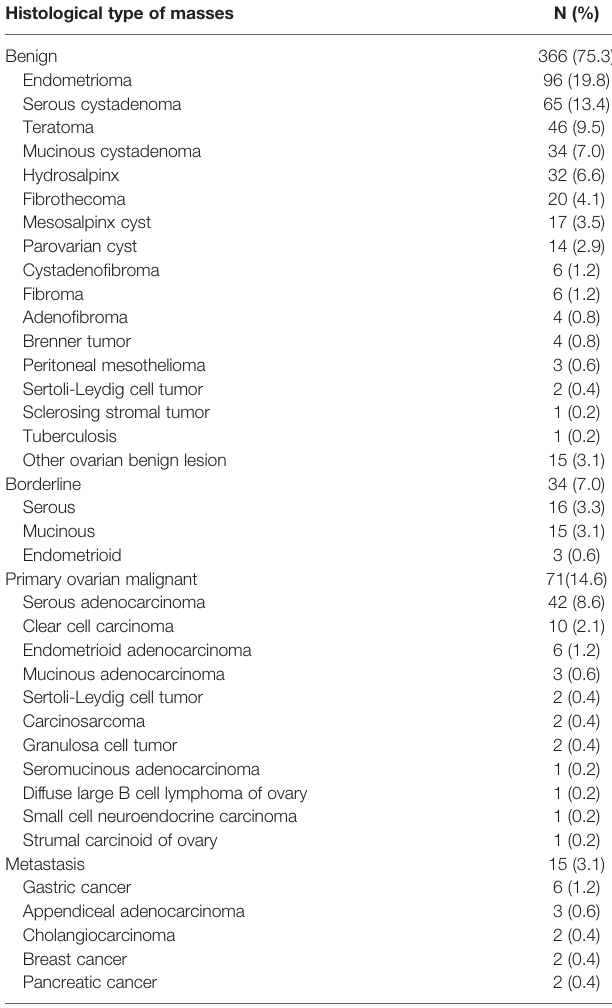
TABLE 1 | Distributions of histology outcomes of 486 adnexal